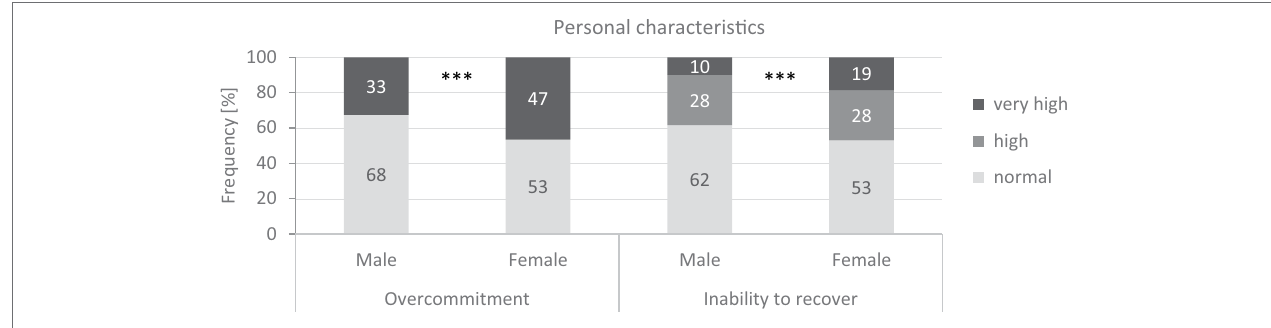
FIGURE 1 | Overcommitment and inability to recover of male ( n = 2,680) and female ( n = 3,429) full-time teachers. Chi-square test according to Pearson (test size: χ 2 -value, effect size: d); significance (two-sided): *** p < 0.001. Effect size according to Cohen (1988): d : 0.20–0.49 = small